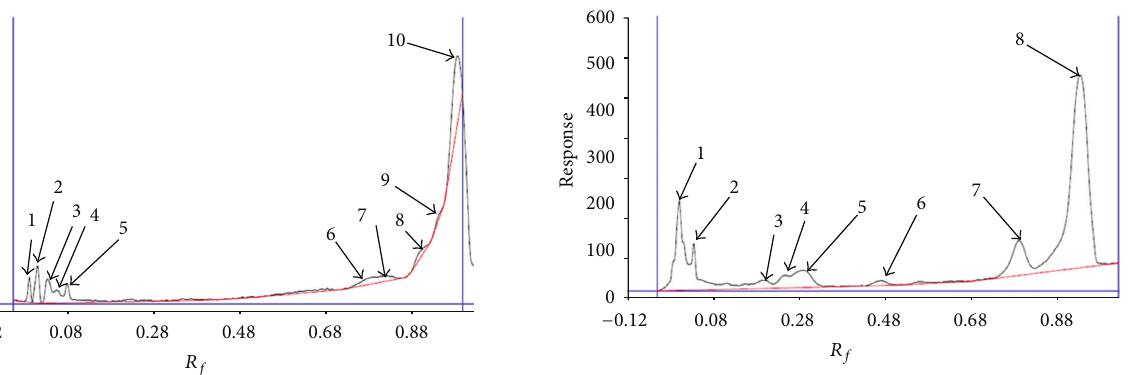
Figure 1: Chromatography of lipids in solvent system containing chloroform-methanol-water (65:25 :4, v/v/v) scanned at 254 nm using Camag HPTLC scanner.